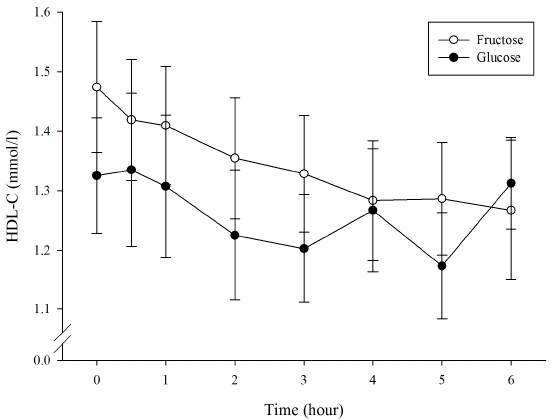
Figure 4. Plasma HDL-C concentrations during the 6 h postprandial period.